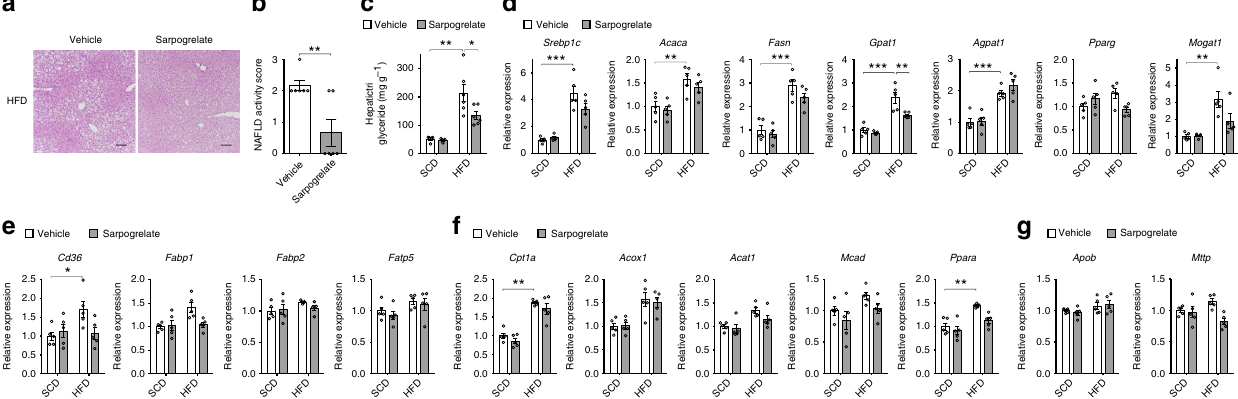
Fig. 6 HTR2A antagonist ameliorates HFD-induced hepatic steatosis. a – g The 12-week-old mice were fed SCD or HFD for 8 weeks and were treated with vehicle or sarpogrelate daily per os. a Representative liver histology by H&E staining from HFD-fed vehicle and sarpogrelate treated mice. Scale bars, 100 μ m. b NAS of HFD-fed vehicle and sarpogrelate-treated mice; n = 6 per group. c Hepatic triglyceride levels; n = 5 – 6 per group. d – g Relative mRNA expression of genes involved in lipogenesis ( d ), FA uptake ( e ), FA oxidation ( f ), and VLDL secretion ( g ) as assessed by qRT-PCR in liver; n = 5 per group. Data are expressed as the means ± SEM. * P < 0.5, ** P < 0.01, *** P < 0.001, Student ’ s t -test ( b ) or one-way ANOVA with post hoc Tukey ’ s test ( c – g